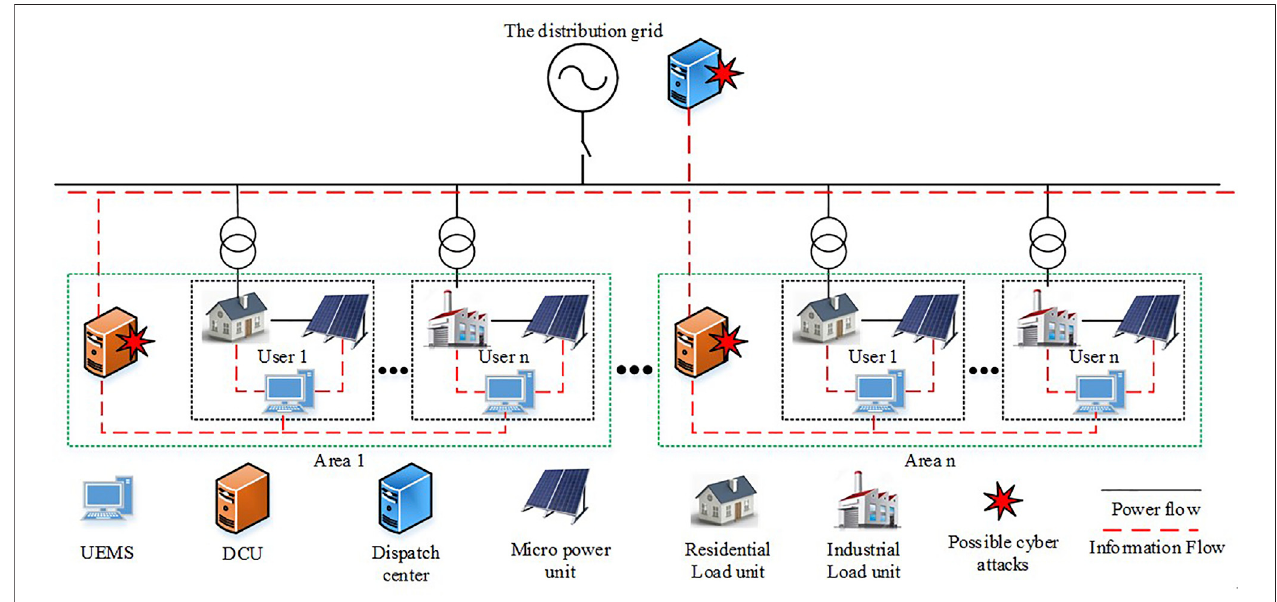
FIGURE 1 | User Energy System architecture under cyber